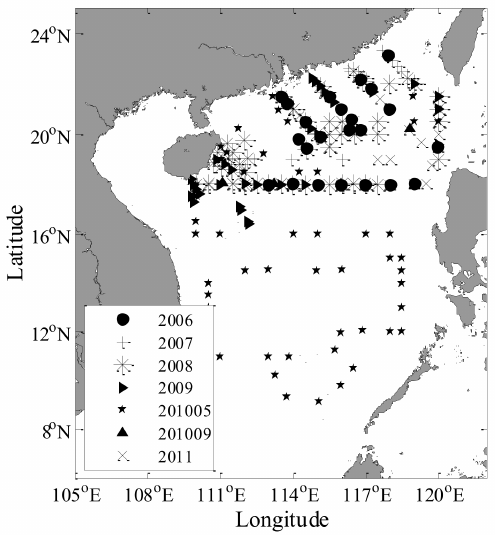
Figure 1. Map of the study area and locations of the in situ water sampling sites in the South China